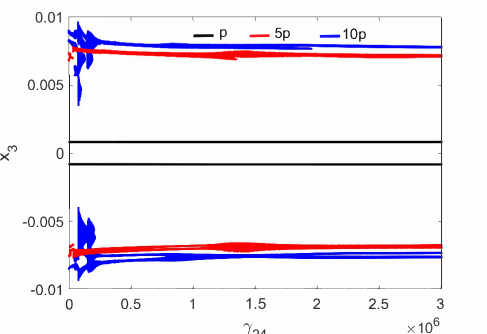
Figure 10. Bifurcation diagrams of the stapes motion in the pathological ear versus the nonlinear stiffness rate of the coupler ( γ 24 ).